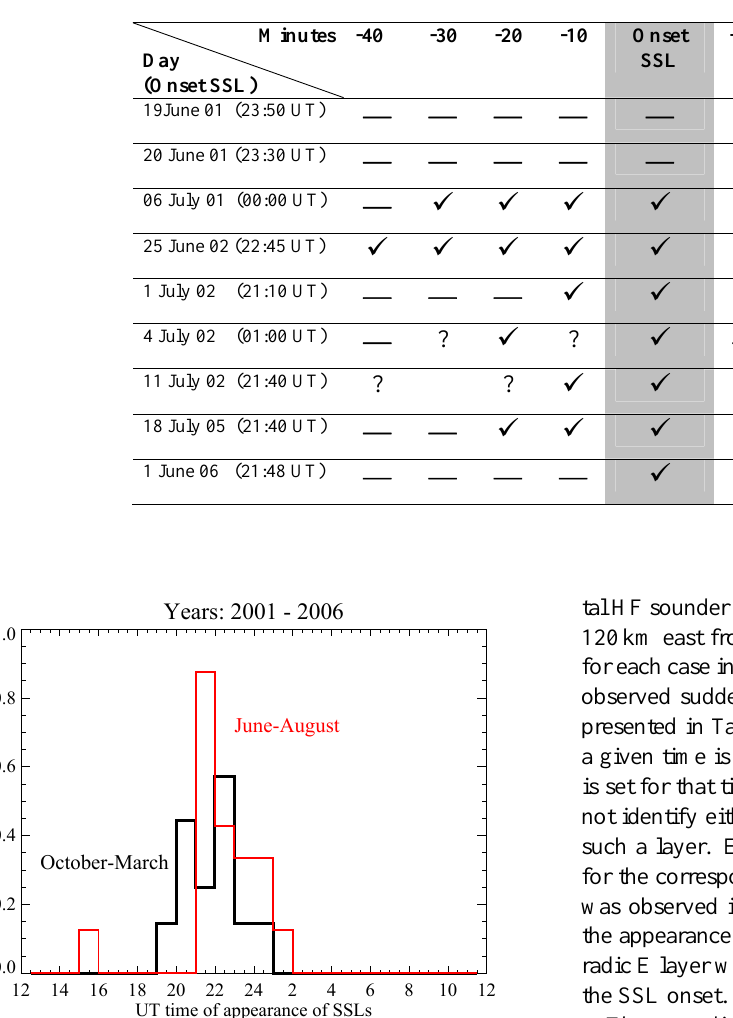
Table 1a and 1b : title to column two and three: Time (UT) should be close to each other (Time (UT) and in the middle between the two columns Table 2 : There should be three different types of signs: minus, check mark and question mark. (One field is empty.) Table 2. Observations of sporadic E-layers at times before and after the arising of a sporadic Na-layer.